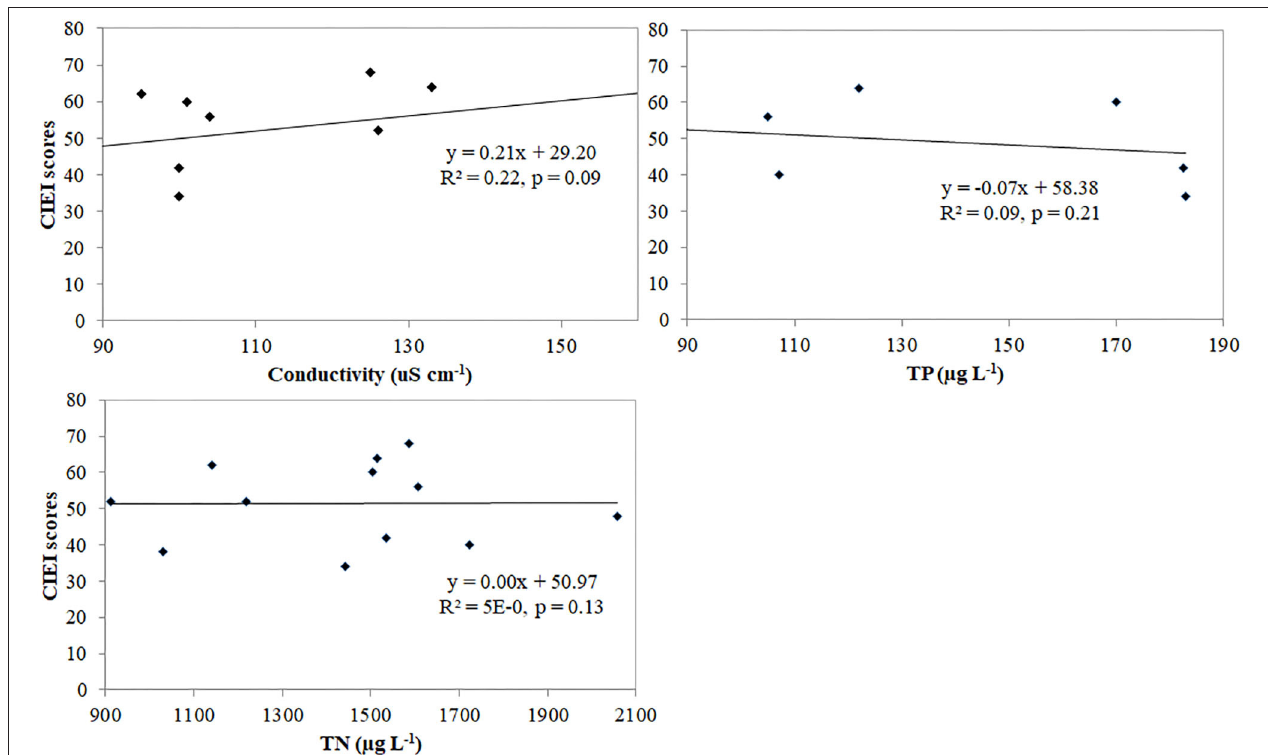
FIGURE 5 | Correlation plots showing further validation and strengthening of the Citizen Index of Ecological Integrity (CIEI) novelty performance for assessing the pollution status of major river catchments in Lake Victoria,